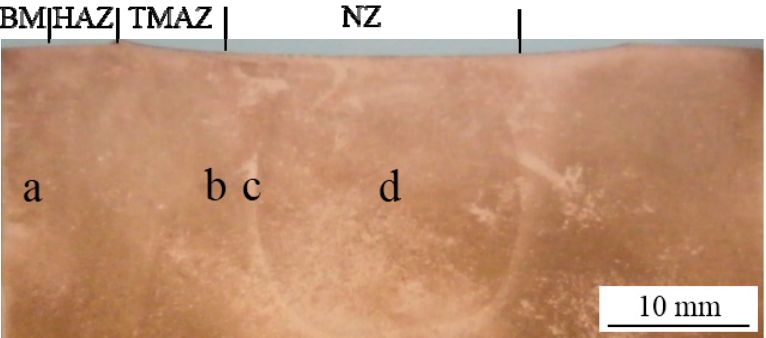
Figure 3. Picture of the cross sections of the friction stir-welded CuCrZr joints, showing the different weld zone regions from base metal (BM) to nugget zone (NZ).